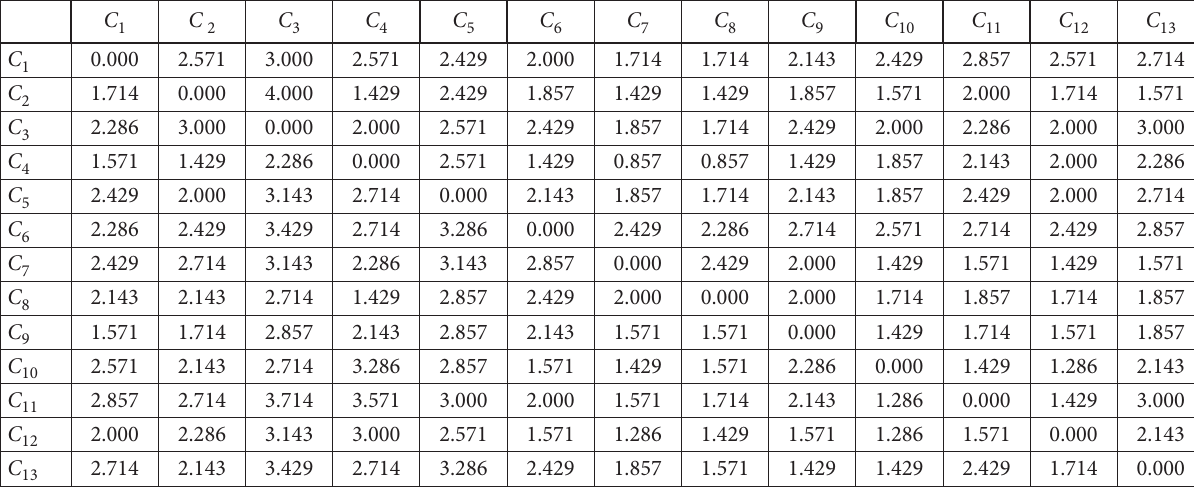
Table 4. Initial influential relation matrix